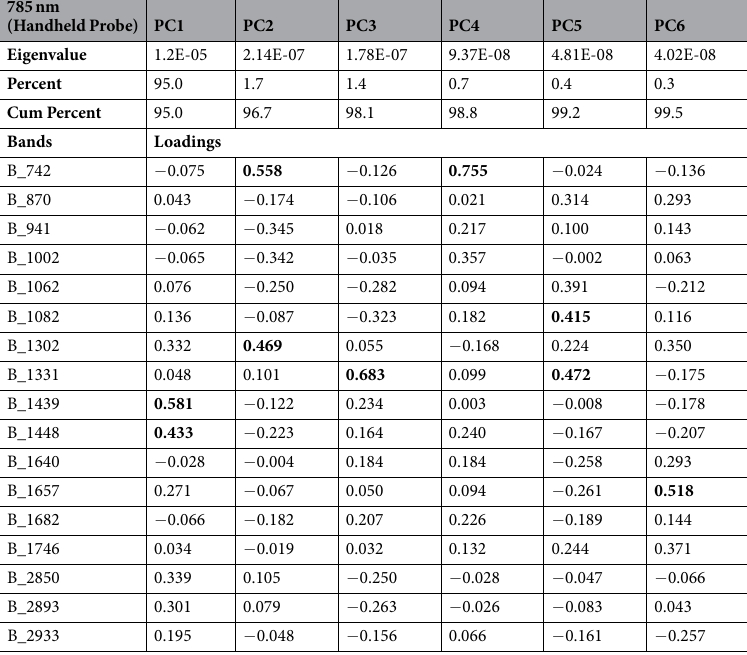
Table 3. Principal component analysis (PCA) extracts 6 eigenvectors accounting for > 99% of the variance in bands from the785 nm device. Data were collected using only the hand-held probe instead of a microscope. Total laser exposure time for each target was 10 seconds. Eigenvector loadings > 0.4 ( + or − ) for each PC appear in